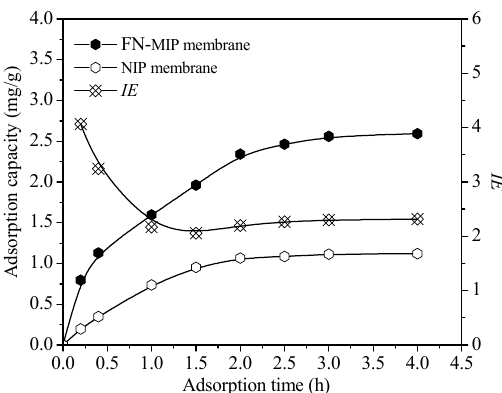
Figure 11. The adsorption dynamic curves of FN on FN-MIP and NIP membrane.